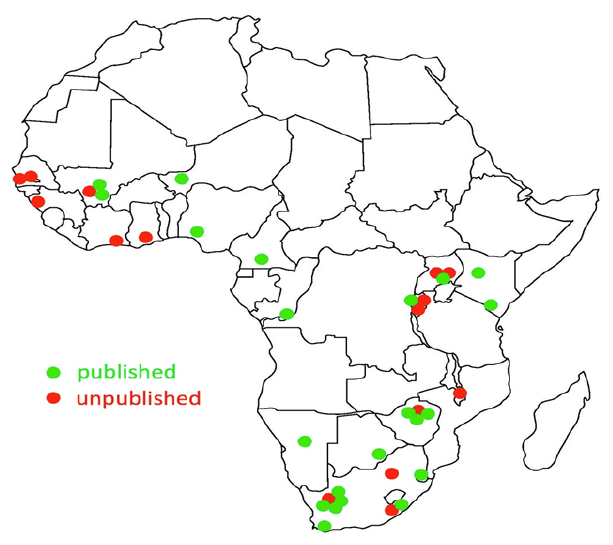
Figure 4 Geographical distribution of data sets. Additional 20 unpublished data sets came from South African Cancer Registry (not